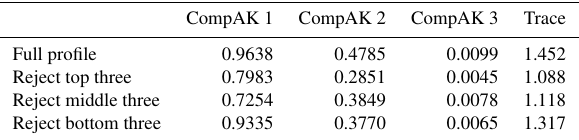
Table 3. Average total and fractional information content for each mode of the averaging kernel for the entire study period. CompAK 1 denotes the average fractional information in mode 1, CompAK 2 is for mode 2, and so forth. Trace denotes the total information con- tent. “Full profile” means all retrievals were assimilated (i.e., none were discarded). “Reject top three” means that retrievals at pressure levels < 300hPa were discarded. “Reject middle three” means that retrievals between 300 and 600hPa were discarded. “Reject bottom three” means that retrievals below 700hPa were